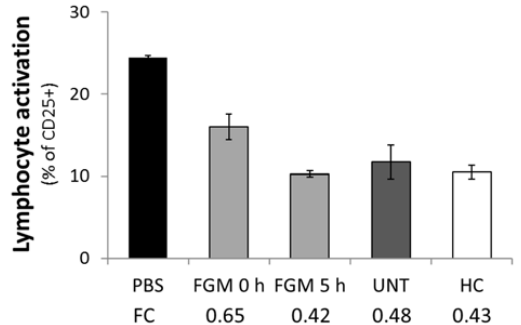
Figure 6. Circulating EVs inhibit lymphocyte activation. Cultured peripheral blood mononuclear cells (PBMCs) were treated with EVs isolated from one donor for each condition (HC, UNT, FGM 0 h, and FGM 5 h) and then activated with PHA addition. In all cases, EVs inhibit lymphocyte activation as shown by flow cytometry analysis of CD25+. Besides, FGM 5 h have impaired inhibition of lymphocyte activation. The fold change (FC) was calculated in respect to the PBS treated sample, and is shown under each bar.